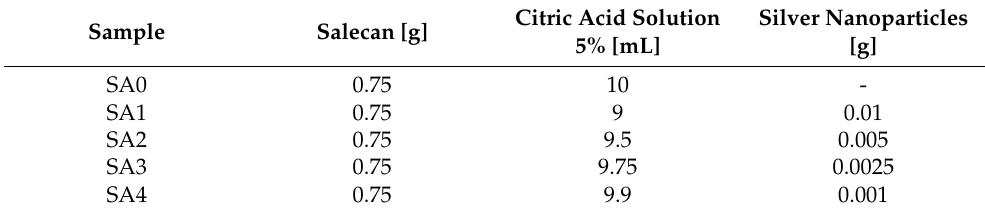
Table 1. Composition of the obtained hydrogels.